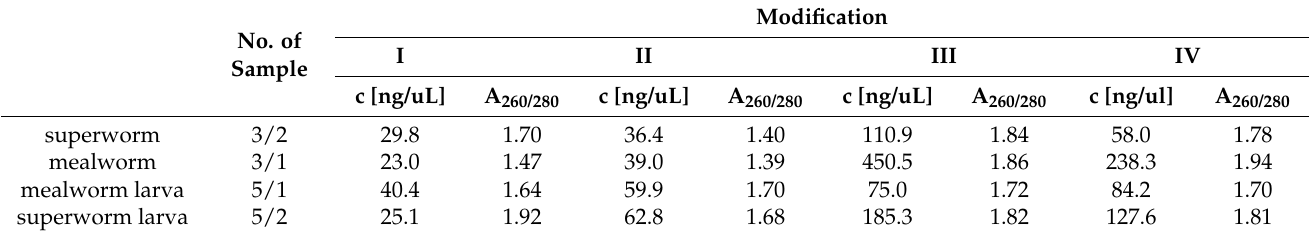
Table 2. Isolation parameters for consecutive DNA extraction modifications. Sample